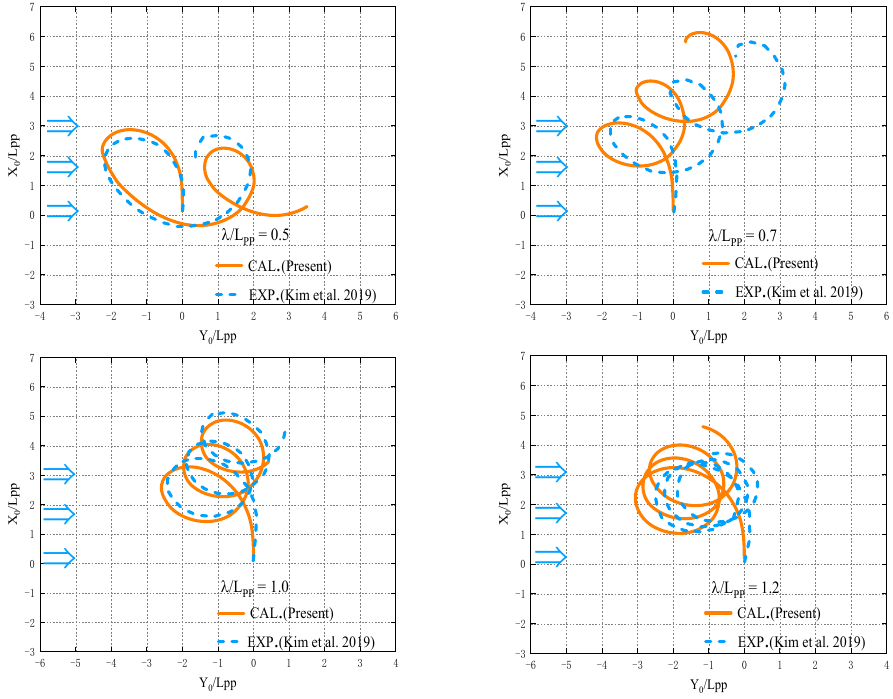
Figure 25. Comparisons of the turning trajectory of +35° turns with the wavelength variation in the beam waves. The experimental values were reproduced from [8], with permission from Elsevier, 2022.